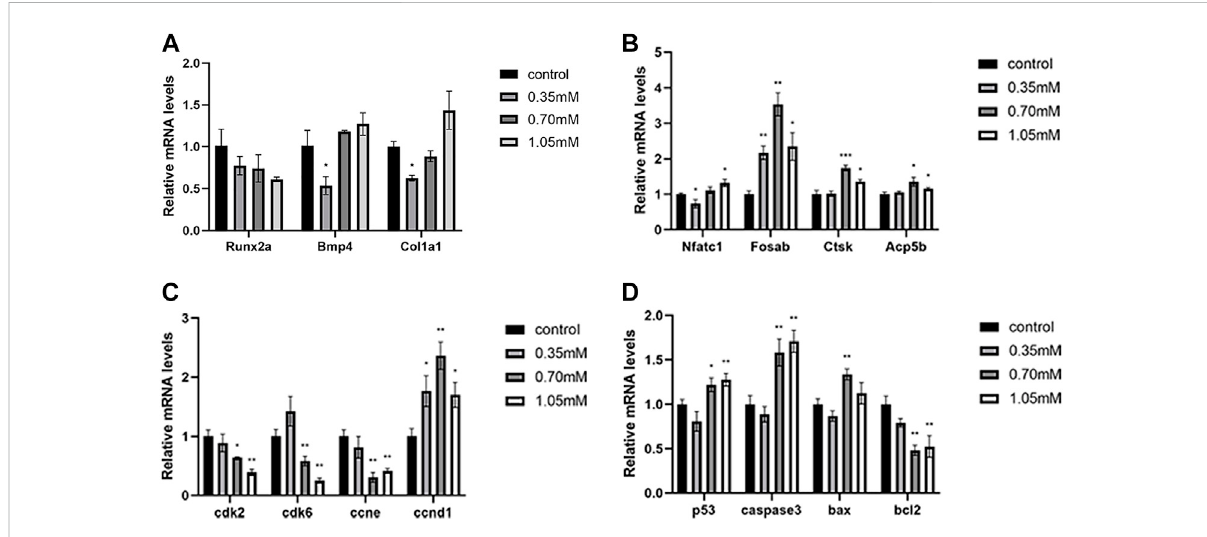
FIGURE 5 Expression analysis of related genes. (A) Expression analysis of osteoblast marker genes. (B) Expression analysis of osteoclast marker genes. (C) Expression analysisofapoptosis-related genes. (D) Expressionanalysisofcellcycleregulatorygenes.* p < 0.05,** p < 0.01,*** p <